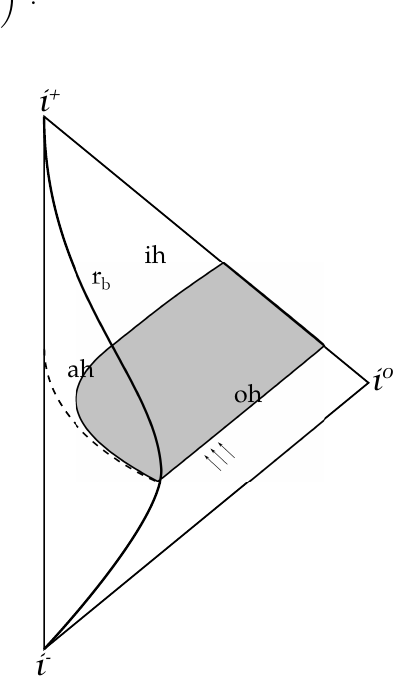
Figure 7. Penrose diagrams of the formation of exotic compact objects from collapse with semi-classical corrections. The thick solid line describes the boundary of the collapsing body r b . Dashed lines describe apparent horizon (curved) and event horizon (straight) in the classical case. Left panel : Quantum effects modify the geometry in the exterior and the outer horizon (oh) shrinks. The outer horizon eventually annihilates with the expanding inner horizon (ih) at the point P , the trapped region (grey area) lives for a finite time. The geometry tends towards the classical case at large distances, while for large t near the compact object (up to a radius greater than the Schwarzschild radius) there are no trapped regions. Right panel : The outer horizon (oh) is well described by the black hole event horizon. Quantum effects result in the formation of an inner horizon (ih) and the system settles to a regular black hole geometry. The trapped region (grey area) is enclosed within the two horizons in the exterior and the apparent horizon (ah) in the interior (solid